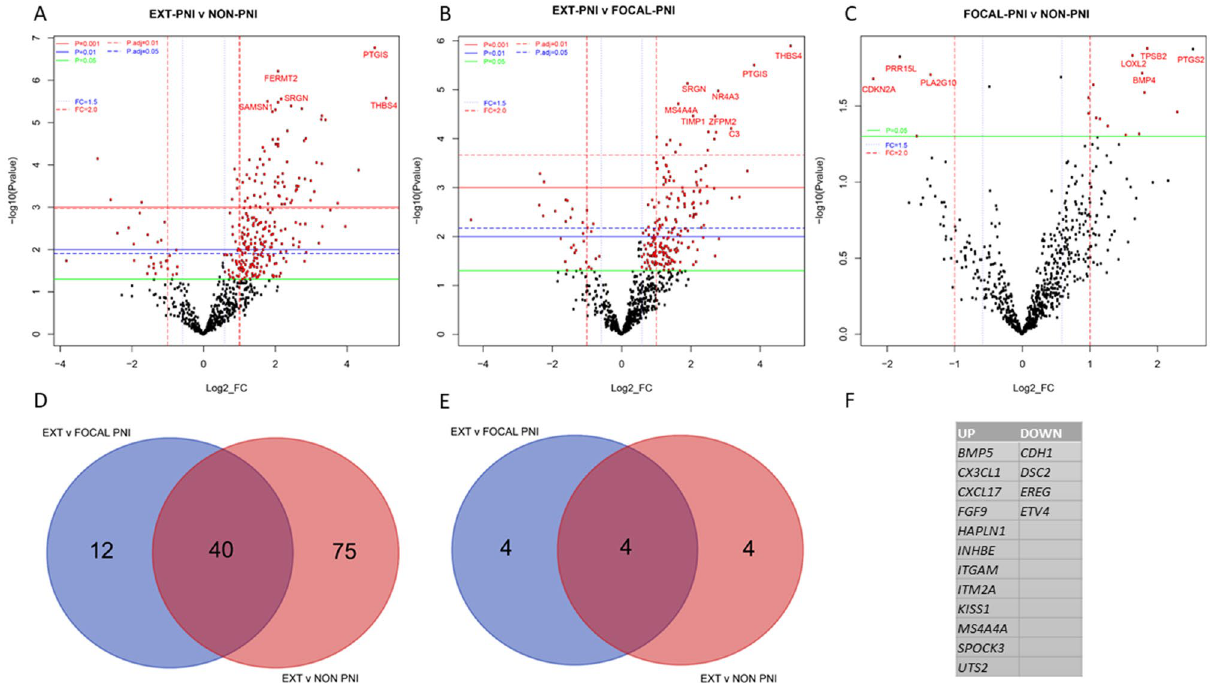
Figure 1. Differential gene expression between PNI cohorts. ( A – C ) Volcano plots showing each gene’s − log10 ( p -value) and log2 fold change of ( A ) EXT-PNI versus Non-PNI, ( B ) EXT-PNI versus Focal-PNI, and ( C ) Focal- PNI versus Non-PNI cohorts. Genes that fall at the top and to either side of the plot are the most significantly DEGs. Dashed colored horizontal lines indicate adjusted p -value thresholds as shown. Solid colored horizontal lines indicate unadjusted p -value thresholds as shown. Dashed coloured vertical lines indicate fold change of ± 1.5 or 2 × (FC = 1.5 and FC = 2.0). The most statistically significant genes are labeled. ( D , E ) Venn diagrams showing DEG with ( D ) ≥ 3 or ( E ) ≤ − 3-fold change between cohorts as shown and adjusted p -values of < 0.01. The number of DEG for each pairwise comparison is indicated in the circles. Blue circles; DEG between EXT vs. Focal-PNI. Orange circles; DEG between EXT vs. Non-PNI. The overlap between the circles (purple) shows shared DEG genes between comparisons. ( F ) Significant up and down DEGs unique to EXT-PNI versus Focal- PNI